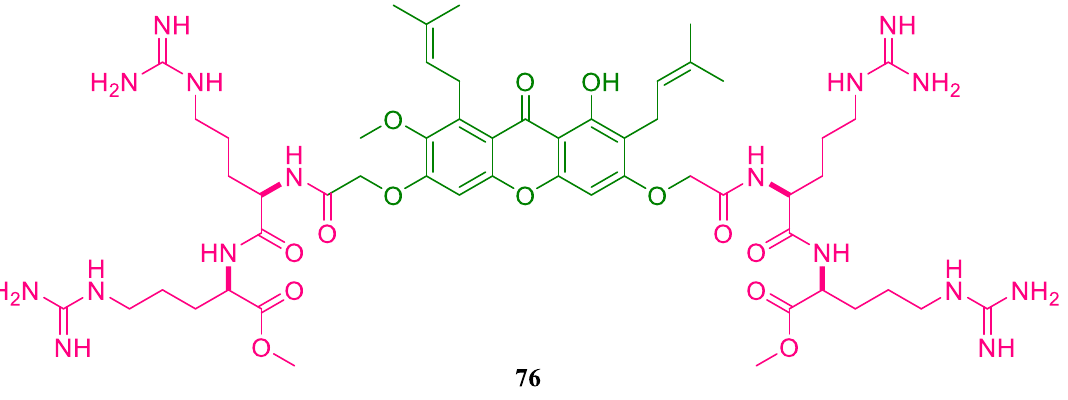
Figure 62. Amino acid-xanthone derivatives.